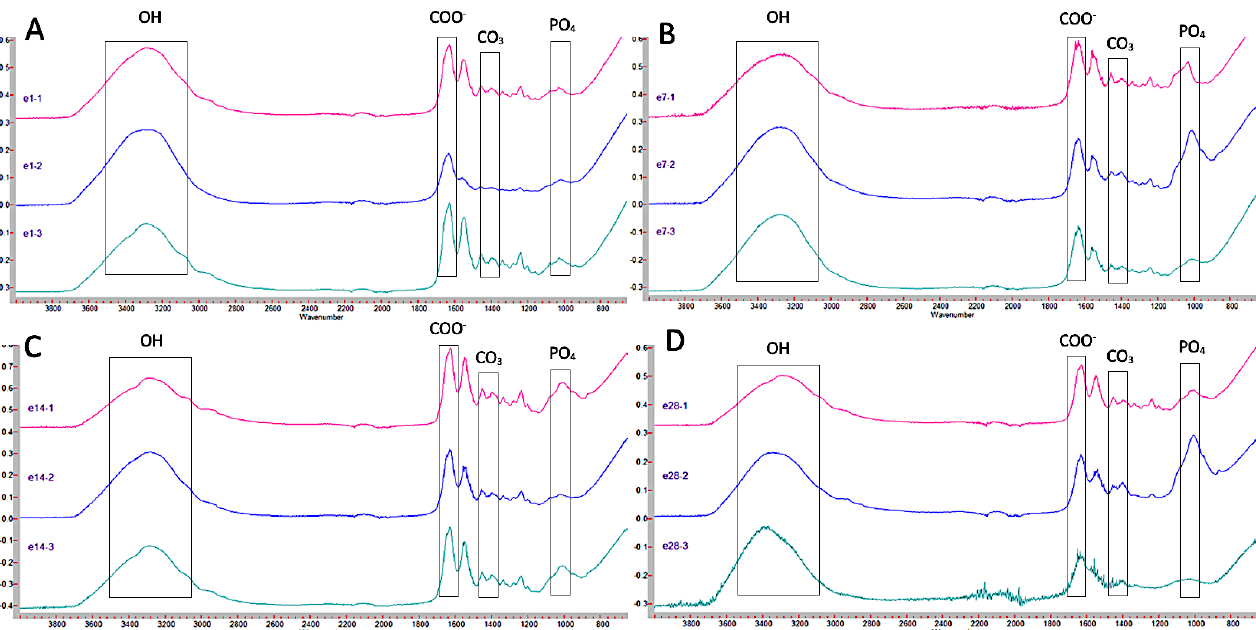
7 of 15 Figure 4. Comparison of Ketac Molar FTIR spectra at different thicknesses (1, 2, and 3 mm) at 24 h ( A ), 7 days ( B ), 14 days ( C ), and 28 days ( D ). The peaks of the OH, COO − , CO 3 , and PO 4 groups of interest in this study are indicated. Figure 5 shows the graphs regarding Equia Forte. At 24 h (Figure 5A), in all thick- nesses, the behavior is similar: a peak corresponding to the presence of OH bonds, fol- lowed by a peak corresponding to water absorption, then several peaks close to 1420 cm − 1 ,